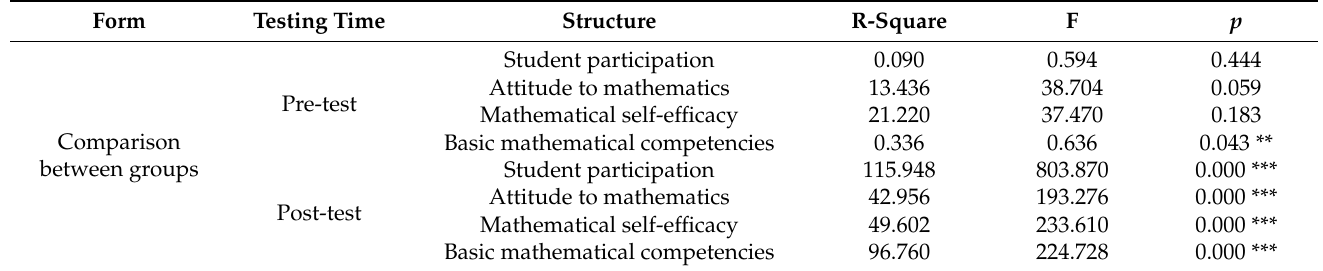
Table 10. Comparison between groups of pre and post-tests in the experimental and control classes.